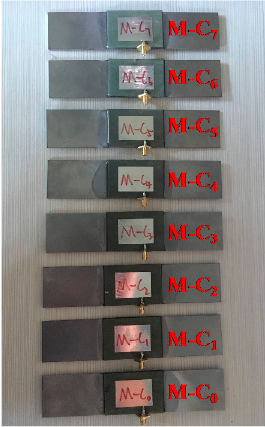
Figure 9. Specimens with crack under CFRP reinforcement layers.